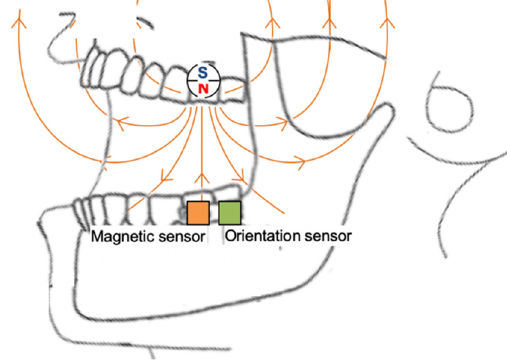
Figure 2. Layout of the components in the proposed system.